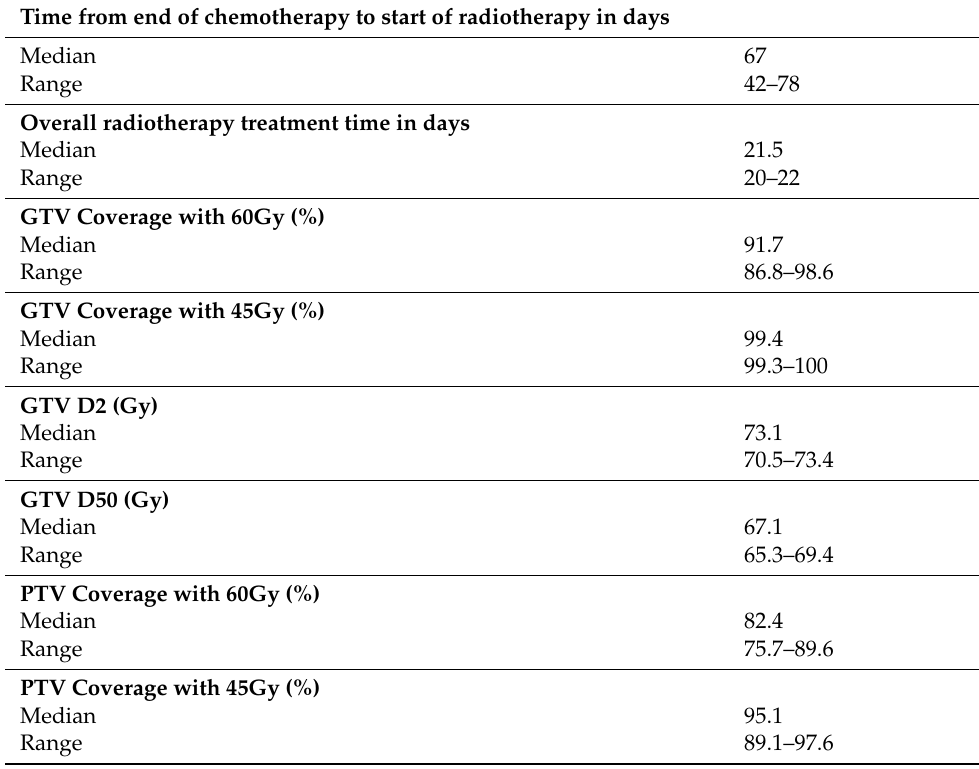
Table 5. Treatment